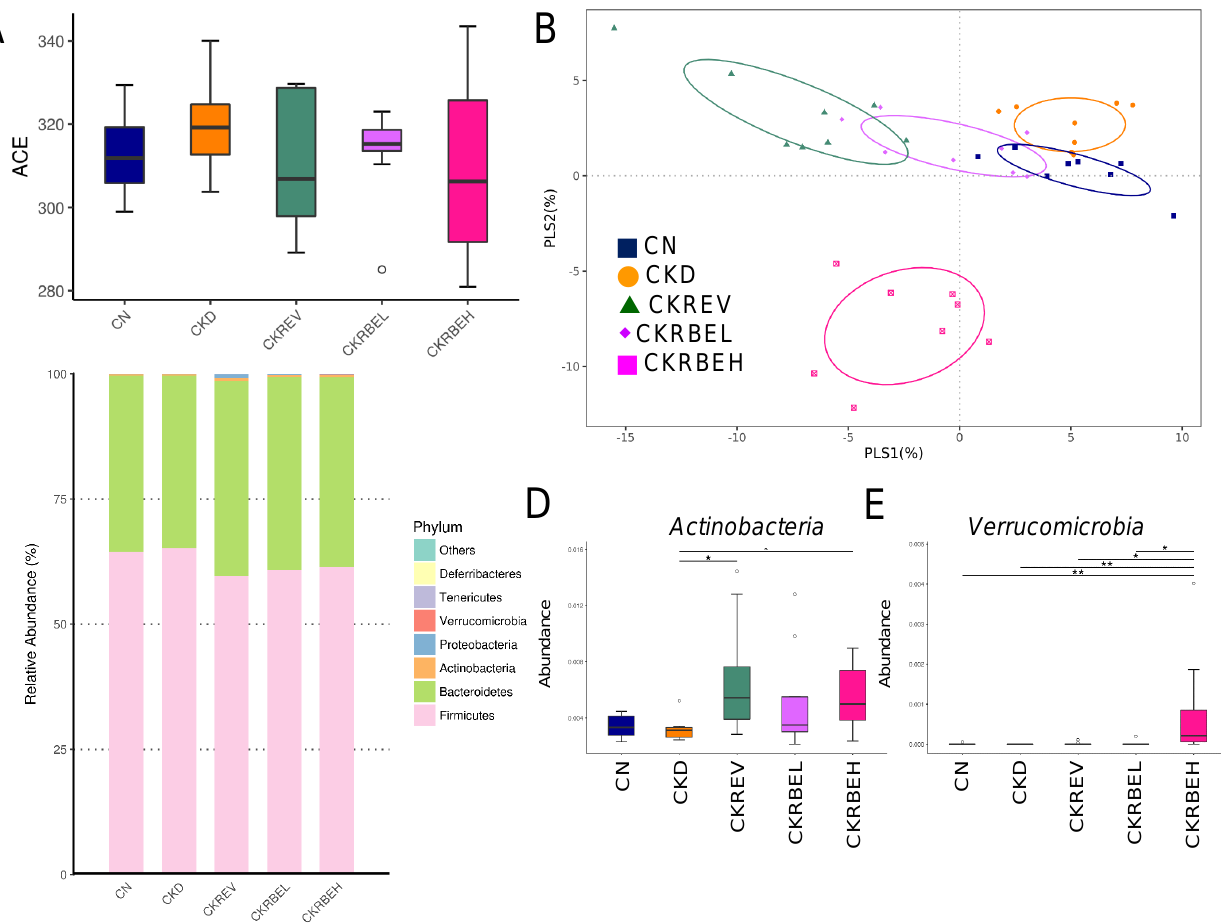
Figure 5. Effect of adenine-induced chronic kidney disease (CKD), resveratrol, or resveratrol bu- tyrate ester on the gut microbiome. ( A ) α -Diversity measured by the abundance-based coverage estimator (ACE) index. ( B ) β -Diversity using the partial least squares discriminant analysis (PLS-DA). ( C ) Relative abundance of the top five phyla of the gut microbiota. Relative abundance of the phyla ( D ) Actinobacteria and ( E ) Verrucomicrobia . N = 8/group; * p < 0.05; ** p <